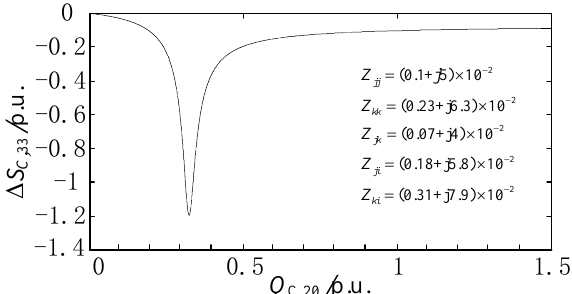
Figure 2. Relationship between the short-circuit capacity deviation and shunt compensation capacity.